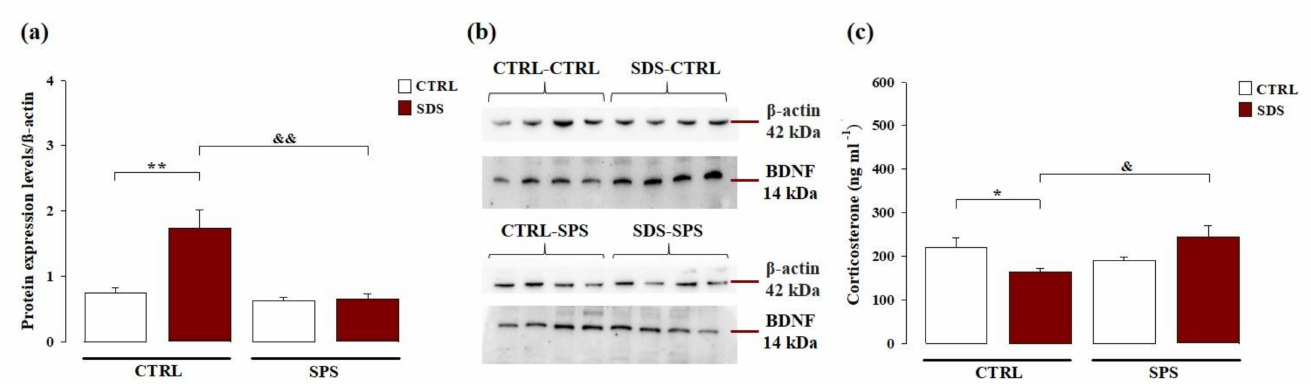
Figure 4. Long-term effects on hippocampal brain-derived neurotrophic factor (BDNF) protein expression and plasma corticosterone levels in rats exposed to SDS, SPS, or the combination of both stressors. ( a ) Western blotting analysis of hippocampal BDNF protein expression levels in adult rats. Data represent means ( ± SEM) from three replicate experiments and are normalized with β -actin and ( b ) representative Western blot bands of four samples. ( c ) Plasma corticosterone levels. Data represent means ( ± SEM) from three replicate experiments. *, p < 0.05 vs. CTRL-CTRL group; **, p < 0.01 vs. CTRL-CTRL group; &, p < 0.01 vs. SDS-CTRL group; &&, p < 0.01 vs. SDS-CTRL group. (N = 6–8 per